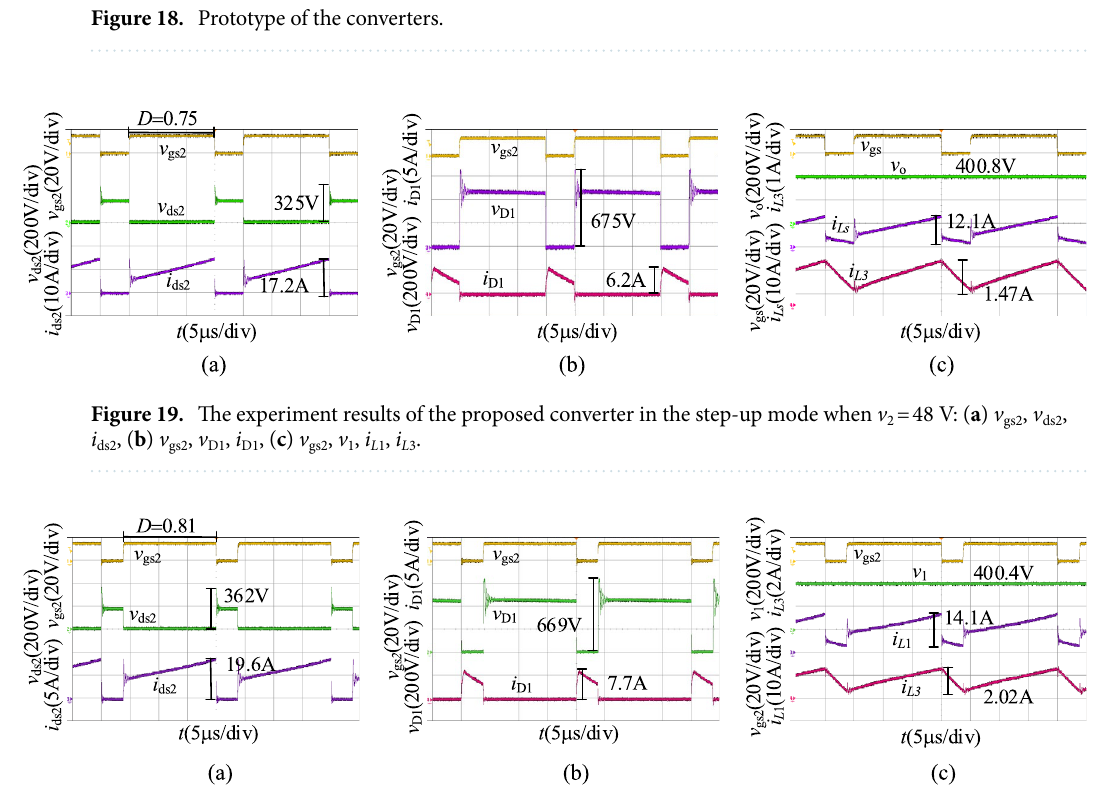
Figure 20. The experiment results of the proposed converter in the step-up mode when v 2 = 36 V: ( a ) v gs2 , v ds2 , i ds2 , ( b ) v gs2 , v D1 , i D1 , ( c ) v gs2 , v 1 , i L 1 , i L 3